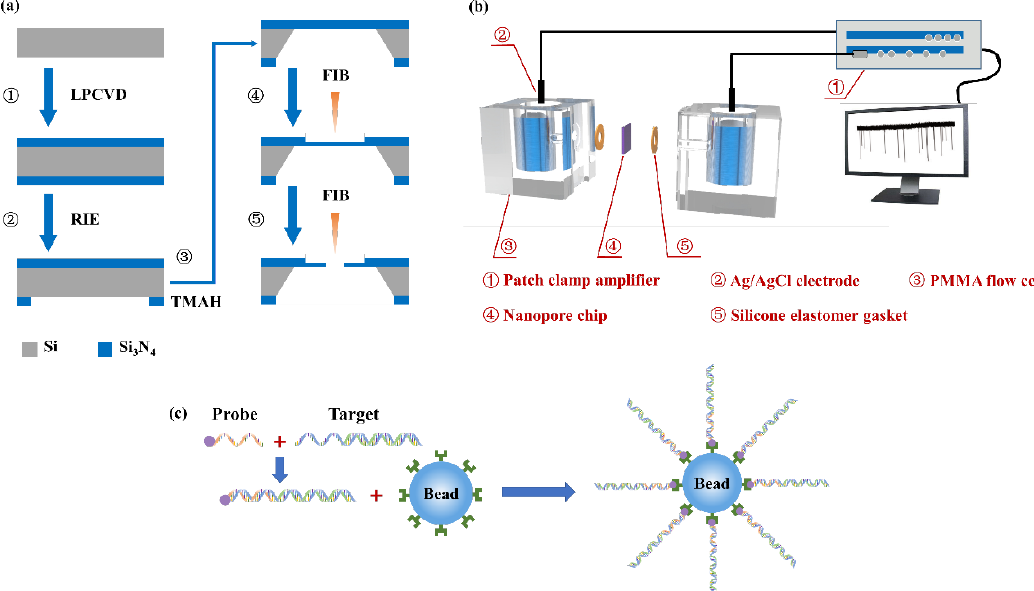
Figure 1. Schematic illustrations of ( a ) the nanopore fabrication process, ( b ) the nanopore-based detection setup and ( c ) the process of DNA selectively binding to the microbead. 96